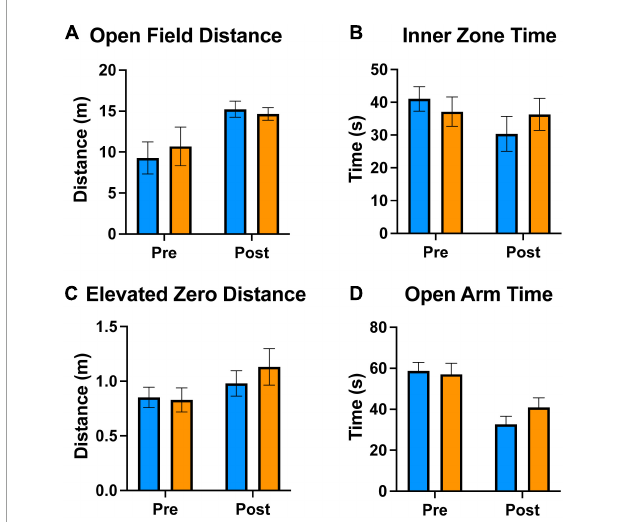
FIGURE2 Tamoxifen treatment does not alter locomotive and anxiety behaviors. (A–D) Results of Open Field and Elevated Zero behavioral assessments; “pre-treatment” time point 1 week prior to tamoxifen or control exposure, “post-treatment” 2 days following completion of treatment (A–D) . (A) Distance traveled in a 5 min Open Field exploration task. (B) Time spent in the Inner Zone of the Open Field. (C) Distance traveled in a 5 min Elevated Zero exploration task. (D) Time spent in the Open Zone of the Elevated Zero apparatus. N = 16 mice per group; mean ± standard